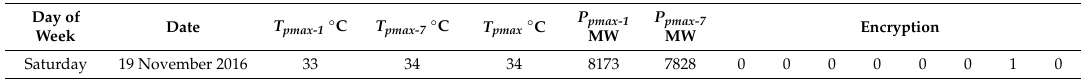
Table 9. The predicted data for peak load of 19 November